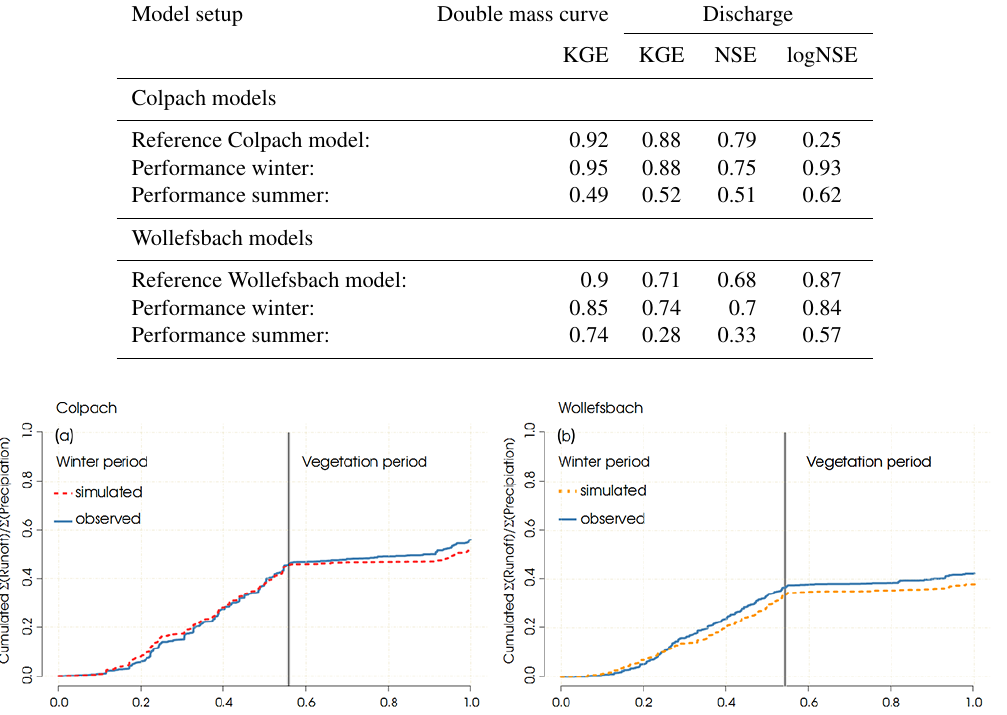
Table 3. Benchmarks for simulated double mass curves and simulated discharge for all model setups used in this study.